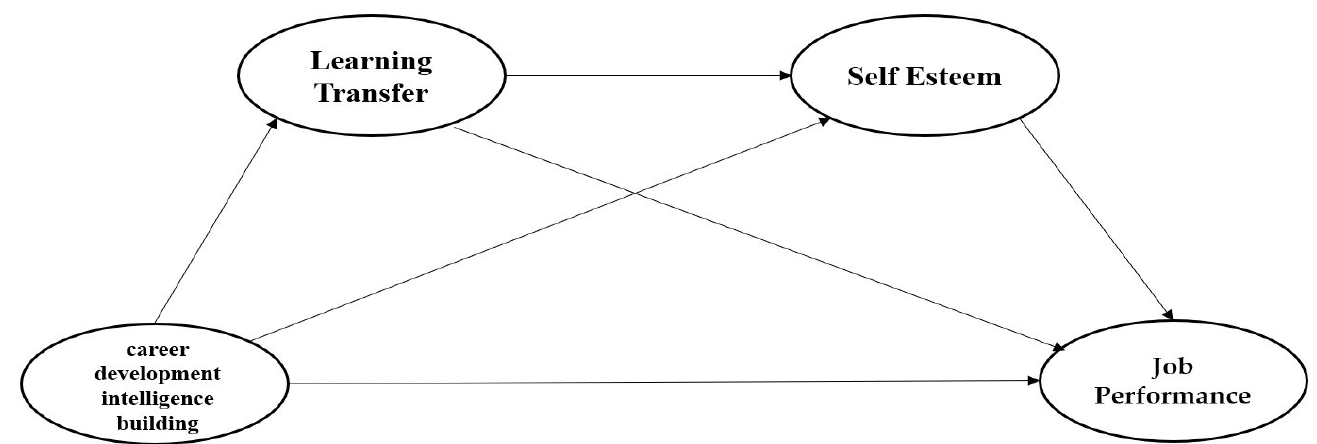
Figure 1. Research Model